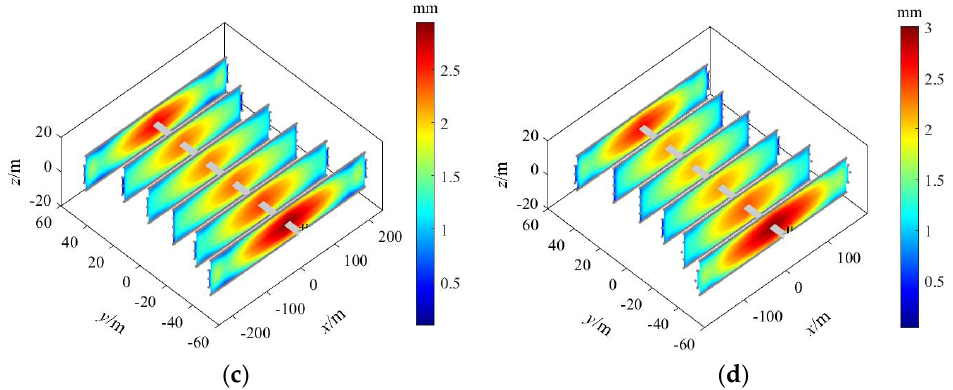
Figure 10. Multiple-fracture propagation patterns under different perforation numbers. ( a ) 3 perforations per cluster; ( b ) 6 perforations per cluster; ( c ) 9 perforations per cluster; ( d ) 12 perforations per cluster.